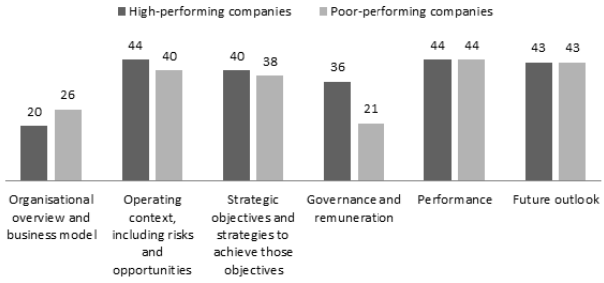
Figure 1: Inclusion of content elements of an integrated report in the chairpersons’ statements of JSE-listed